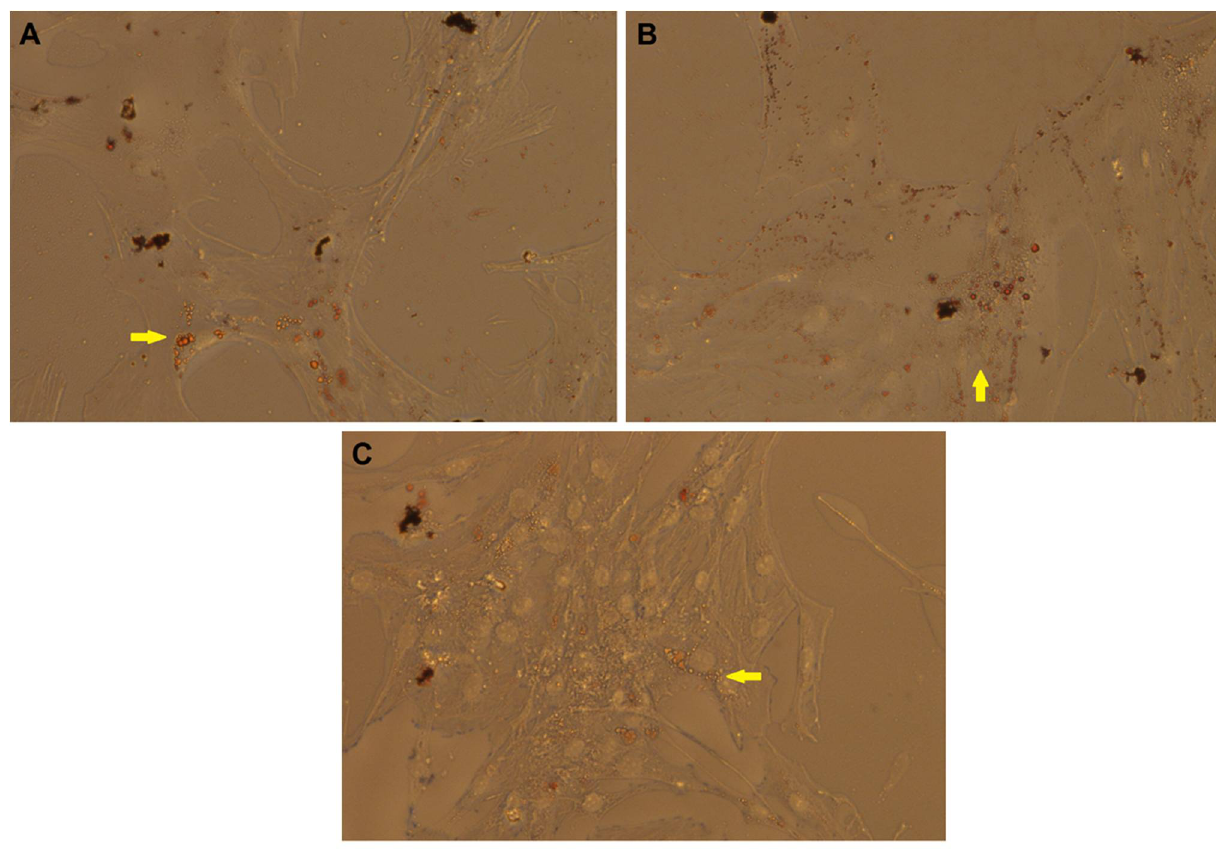
Figure 1. Representative Oil Red O staining of dedifferentiated adipocyte-derived progeny (DFAT) cells at 48 h. ( A ) DFAT cells untreated; ( B ) DFAT cells treated with 100 µM resveratrol; ( C ) DFAT cells treated with 200 µM resveratrol. Lipid droplets stained in yellow color (marked).